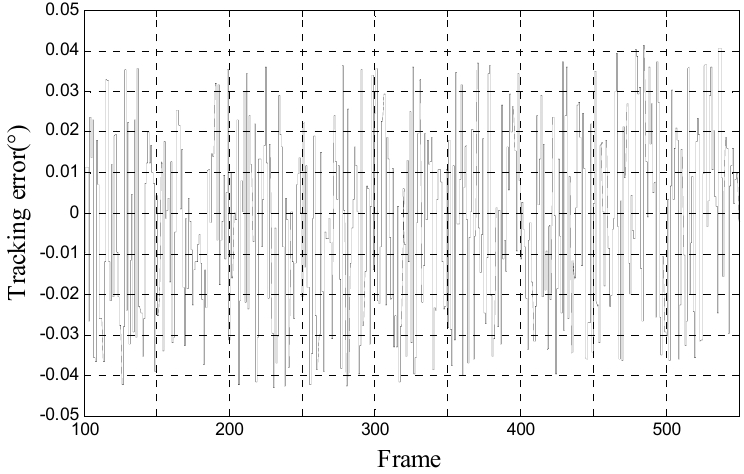
Figure 10. Tracking error of proposed method when moving-target move with 10° 0.05 Hz .